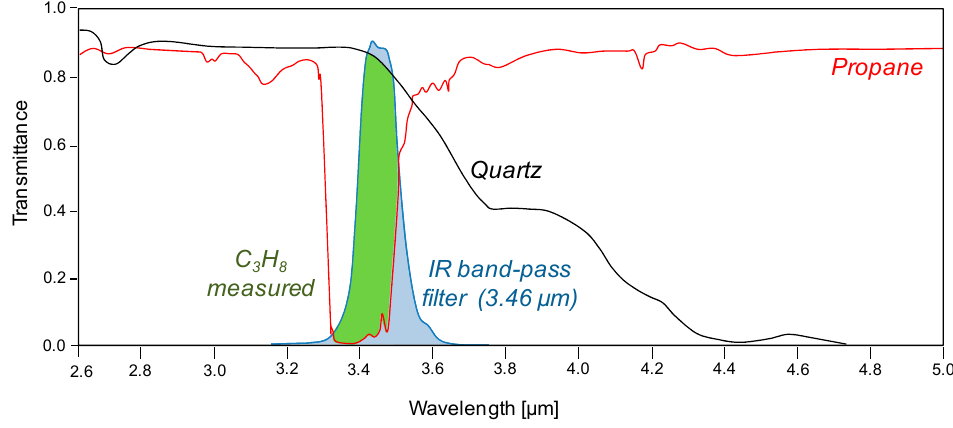
Figure 2. Schematic representation of the IR absorption when using C 3 H 8 as tracer gas in a quartz column.